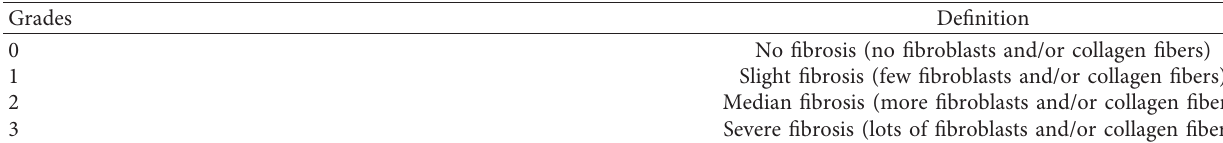
Table 2: Definitions of histopathologic fibrosis